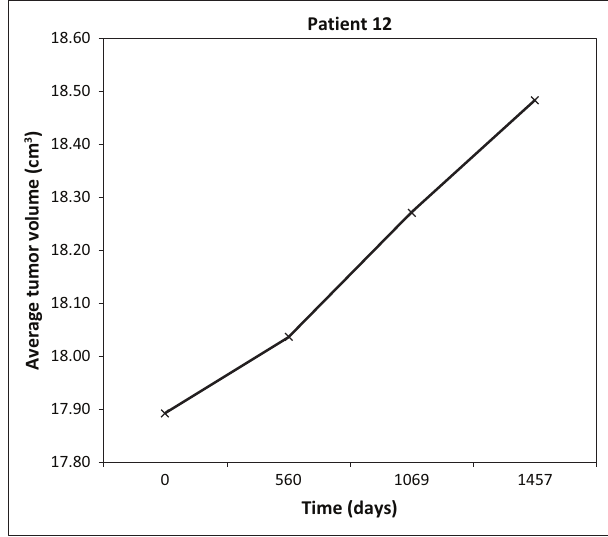
FIGURE 3: Macroadenoma growth observed in a 46-year-old male.